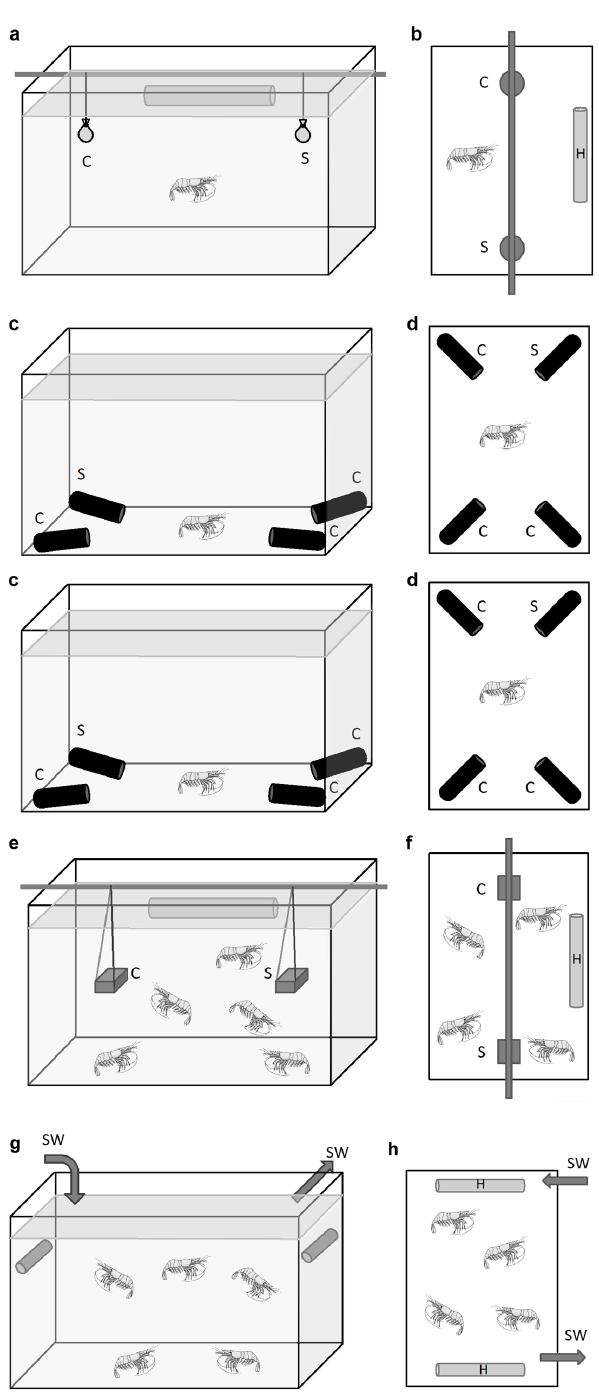
Figure 5. Experimental setups for experiments in aquaria at atmospheric pressure. Perspective ( a ) and birds eye ( b ) views of the experimental setup for two-choice experiments on single P. elegans and M. fortunata . The shrimp was placed in the aquarium ( P. elegans , room temperature; M. fortunata , 10 ◦ C) and left to explore for 5 min. Two gauze bags (one control (C), one stimulus (S)) were introduced on each side of the tank. The shrimp were observed for 5 min. Perspective ( c ) and